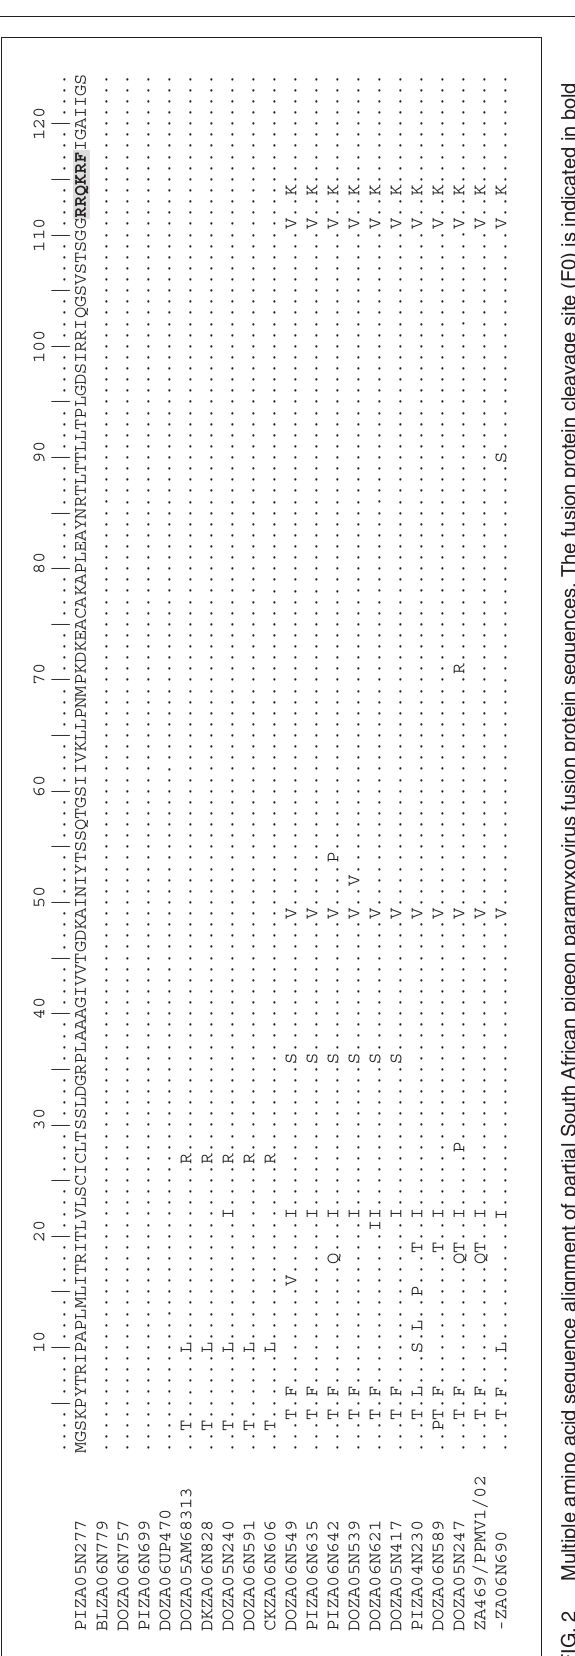
MGSKPYTRIPAPLMLITRITLVLSCI